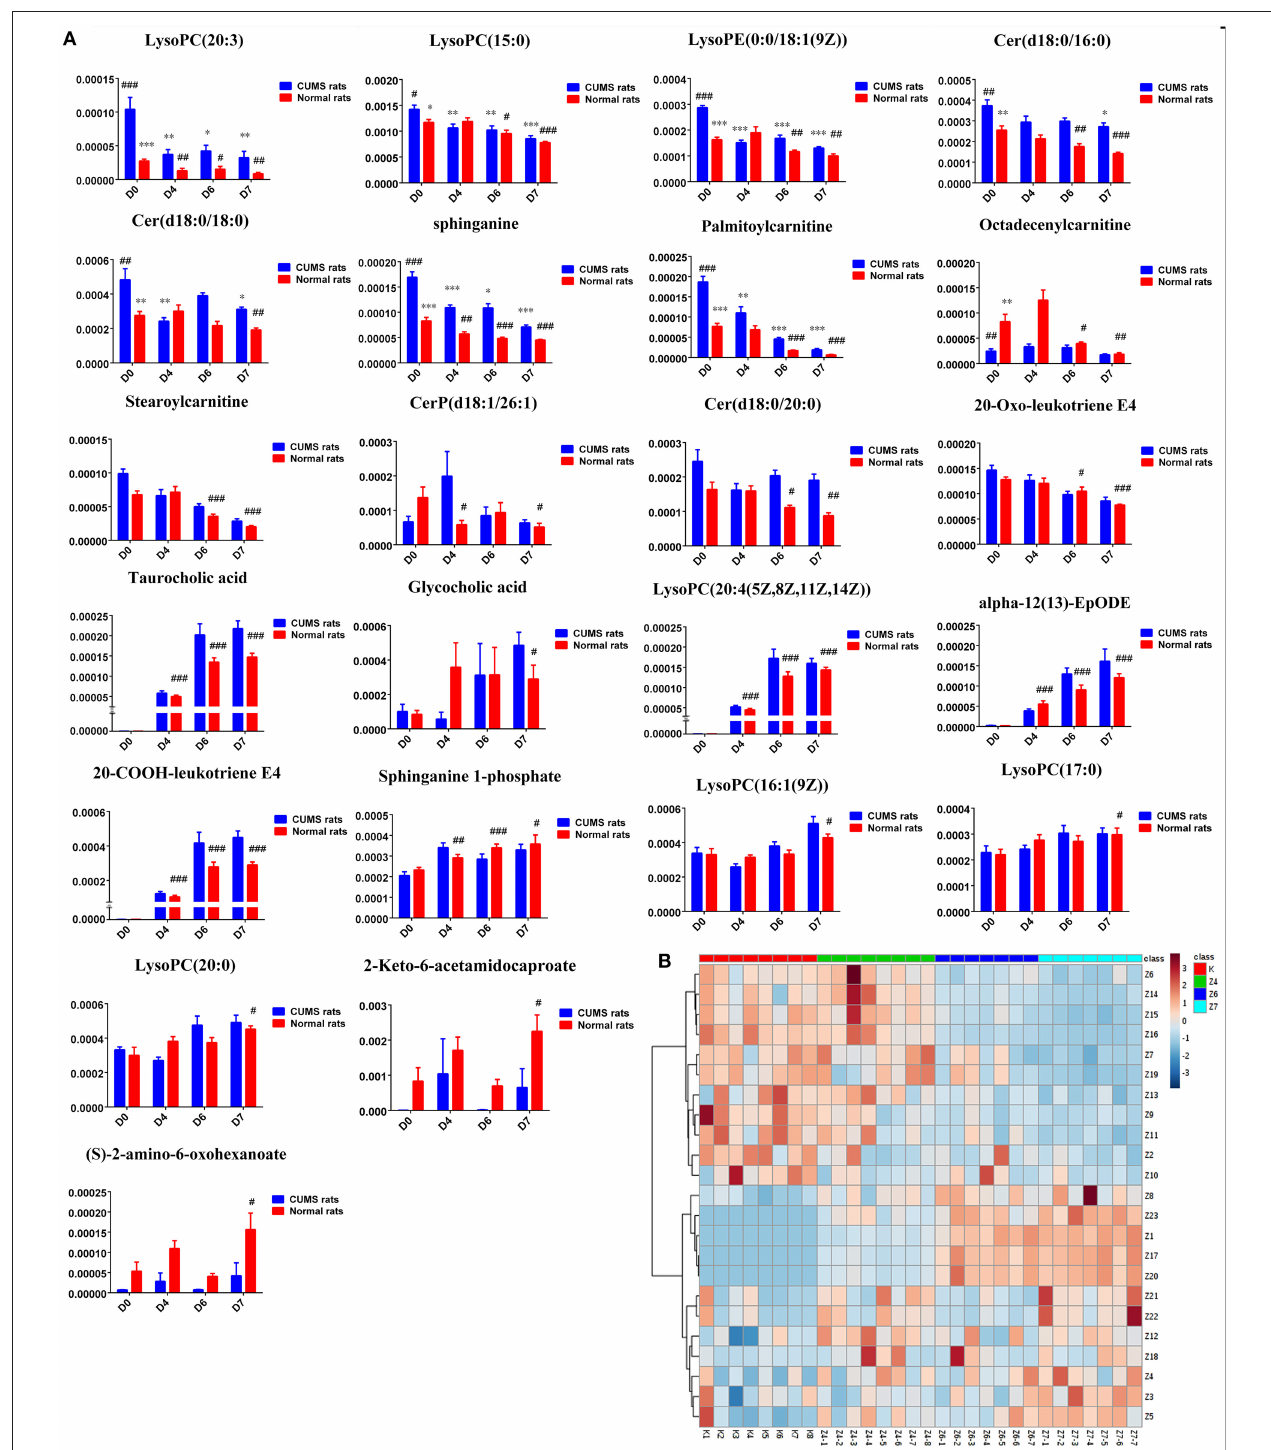
FIGURE 7 | (A) Normalized intensity levels of potential biomarkers in serum samples of normal rats ( red), and the relative content of the corresponding metabolites in CUMS rats ( blue). D0: administration of equal volumes of vehicle. D4: the concentration of PBR was 1.25g/ml (expressed as the weight of raw materials). D6: the concentration of PBR was 5.0g/ml. D7: the concentration of PBR was 10.0g/ml. Data are presented as mean ± SEM. n = 8 each group. * P < 0.05, ** P < 0.01, *** P < 0.001 vs. [CM] group; # P < 0.05, ## P < 0.01, ### P < 0.001 vs. [K] group. (B) : the relative content of the heatmap of differential metabolites in serum samples of healthy rats with PBR administration. Class K: the [K] group. Class Z4: the [Z4] group. Class Z6: the [Z6] group. Class Z7: the [Z7] group. The ribbon − 3 ∼ 3: represents the relative content of the differential metabolites from low to high.